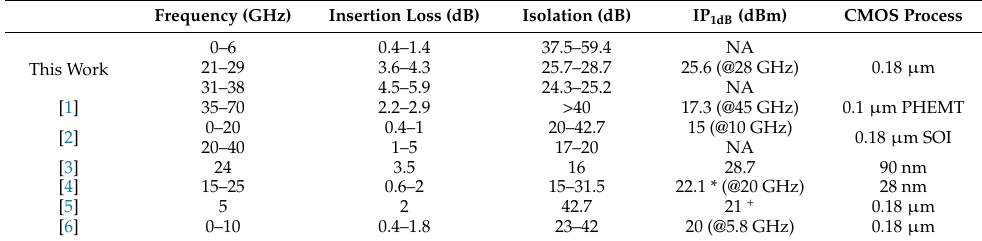
Figure 2. Circuit diagram and chip photo of the DC-38 GHz SPDT switch. Table 1. Summary of this work and recently reported SPDT switches.